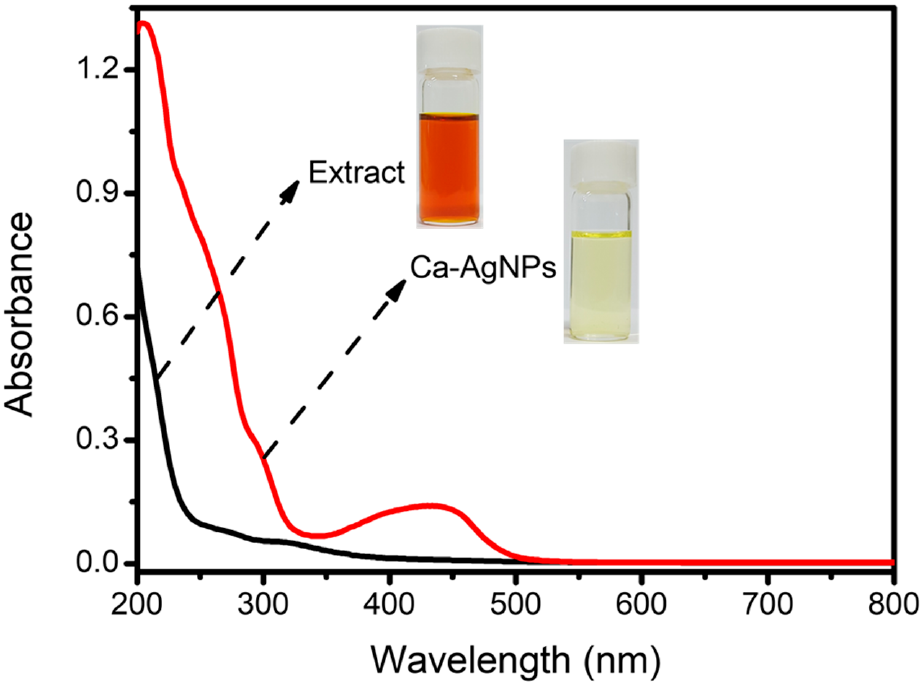
Figure 1. UV spectra of the flower extract and Ca-AgNPs synthesized from the Cassia auriculate flower extract.